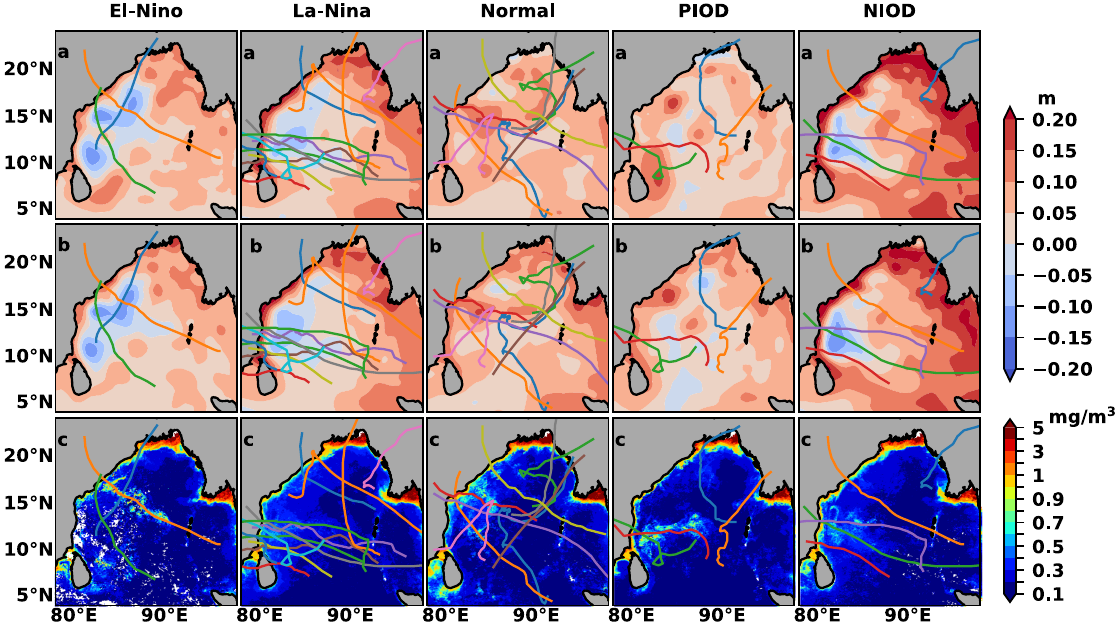
Fig. 8 The differences in Chl-a during El Niño, La Niña, normal, PIOD and NIOD years. The SSHA a 10-day before and b during the passage of cyclone) and Chl-a composite maps with respect to El Niño, La Niña, normal, PIOD and NIOD years in the BoB. The respective cyclone tracks are also